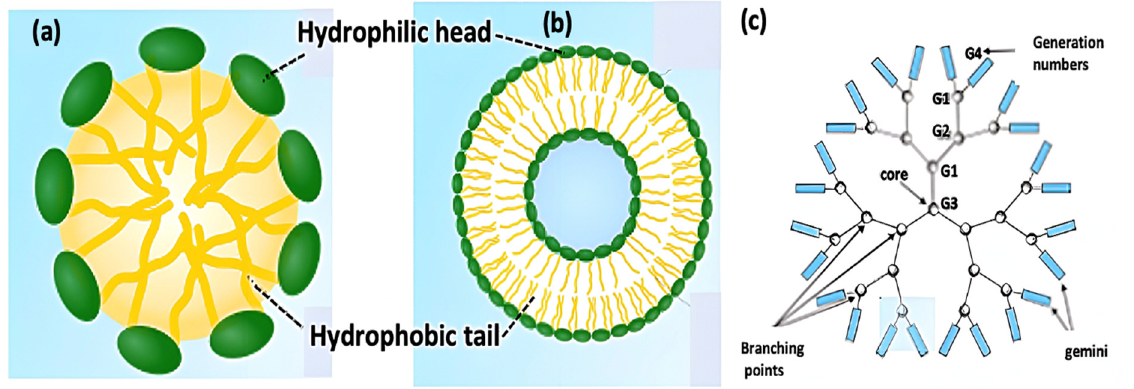
Figure 8. Representation of the structure of micelles ( a ), liposomes ( b ) and dendrimers ( c